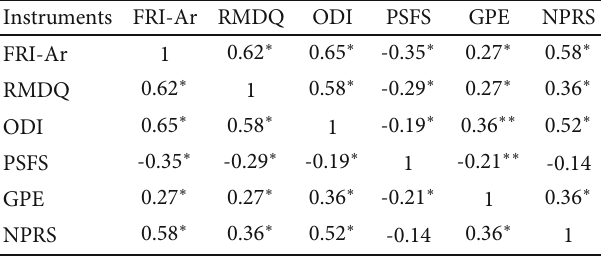
Instruments FRI-Ar